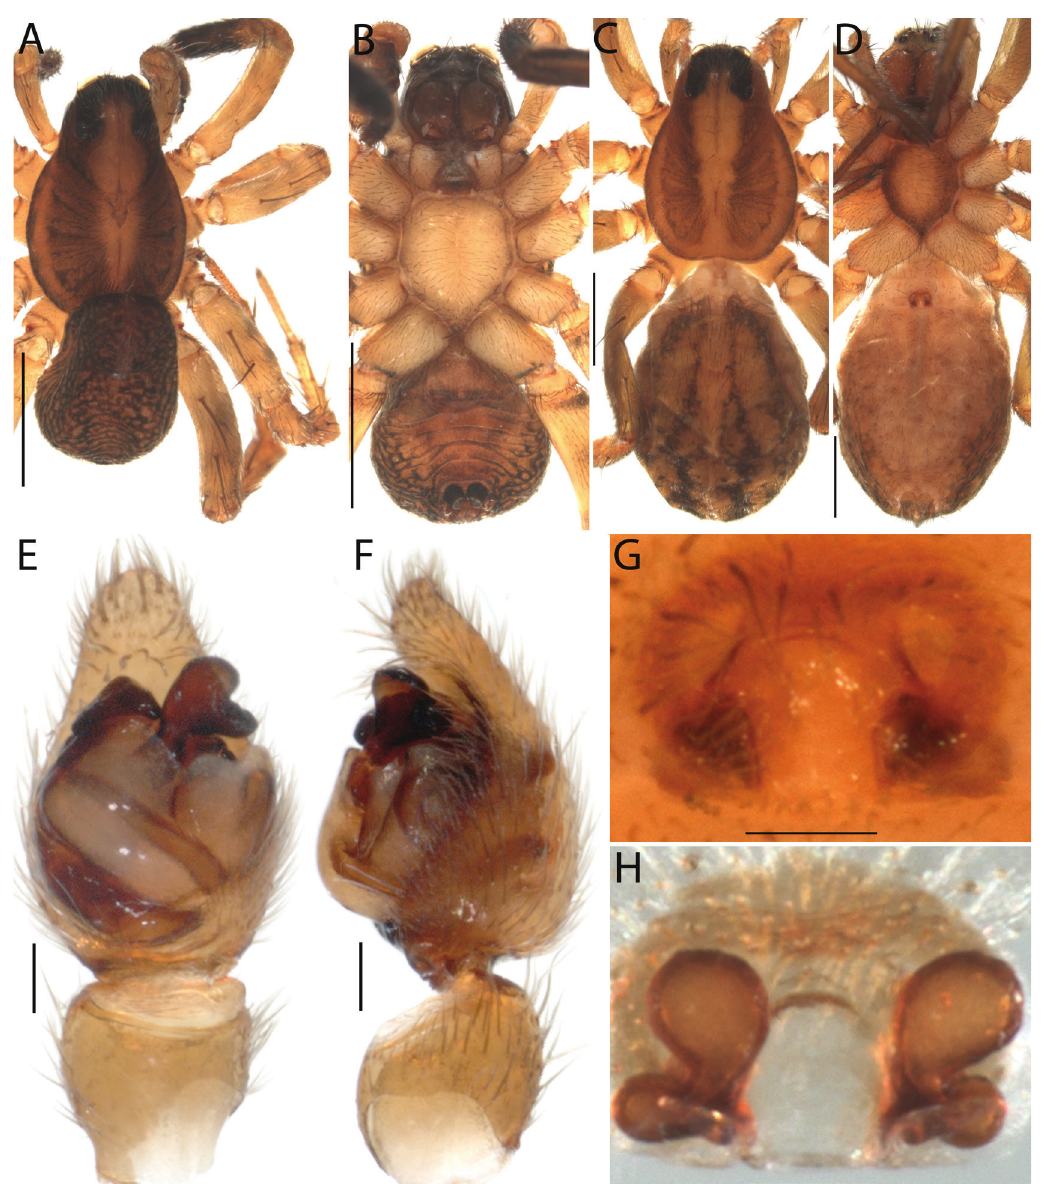
Figure 17. Artoria equipalus sp. n., male holotype (AM KS128077), female paratype (AM KS122934): A , male habitus, dorsal view; B , male habitus, ventral view; C , female habitus, dorsal view; D , female habitus, ventral view; E, male pedipalp, ventral view; F , male pedipalp, retrolateral view; G , epigyne, ventral view; H , epigyne, dorsal view. Scale bars: habitus 1.0 mm; pedipalp, epigyne 0.1